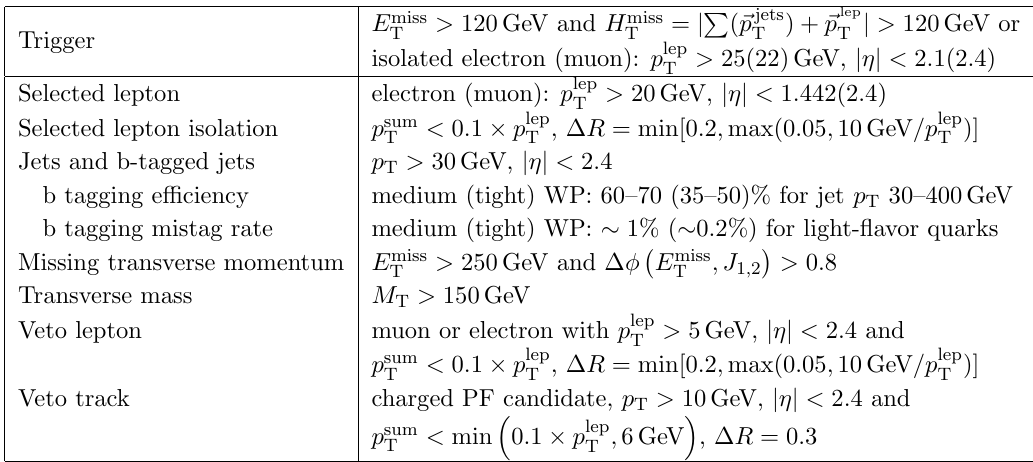
denotes the p T of the lepton, while T